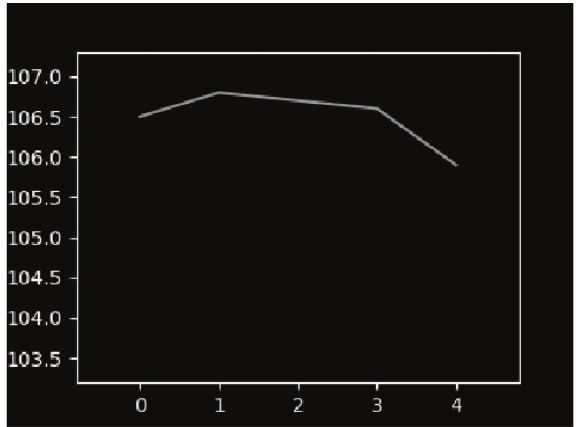
Figure 10: Image Data Only with Price Line Preprocessed with